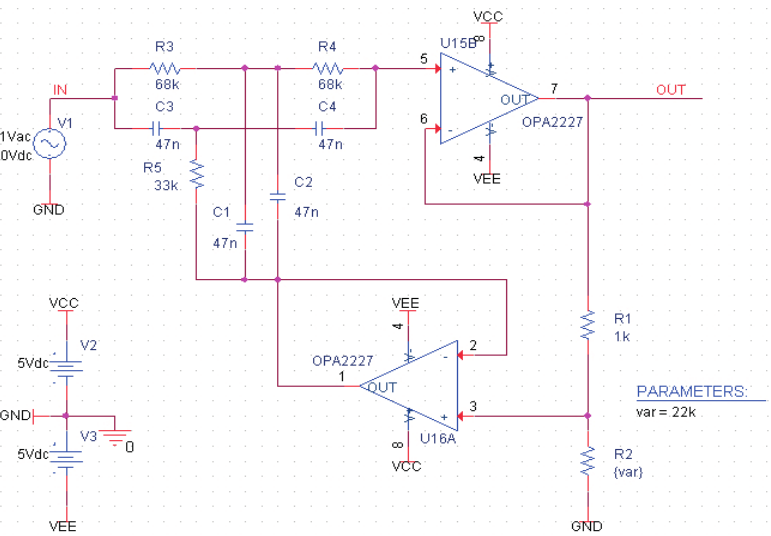
Figure 9. Schematics of double T 50 Hz notch filter topology.